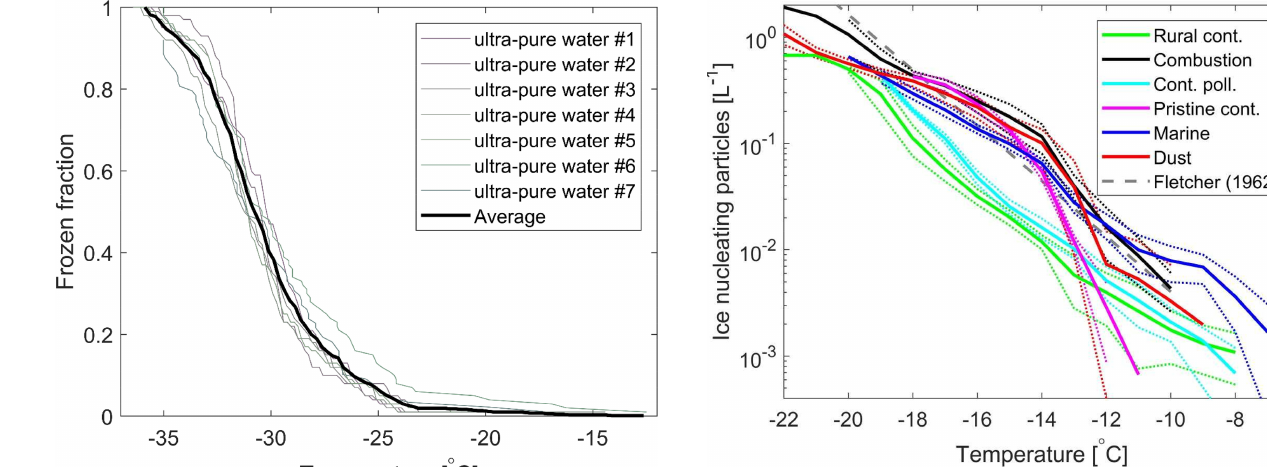
Figure 5. The frozen fraction of ultra-pure water droplets (volume 1µL) for seven different experiments. The average for all runs is in- cluded. In the vast majority of such runs, the first droplet typically freezes for a temperature slightly below − 20 ◦ C. Within the pre- sented ensemble, one sample shows an elevated and unusually high number of droplets frozen for temperatures above − 20 ◦ C. Those observations were most likely associated with unusually poor qual- ity of the glass slides used in that experiment.